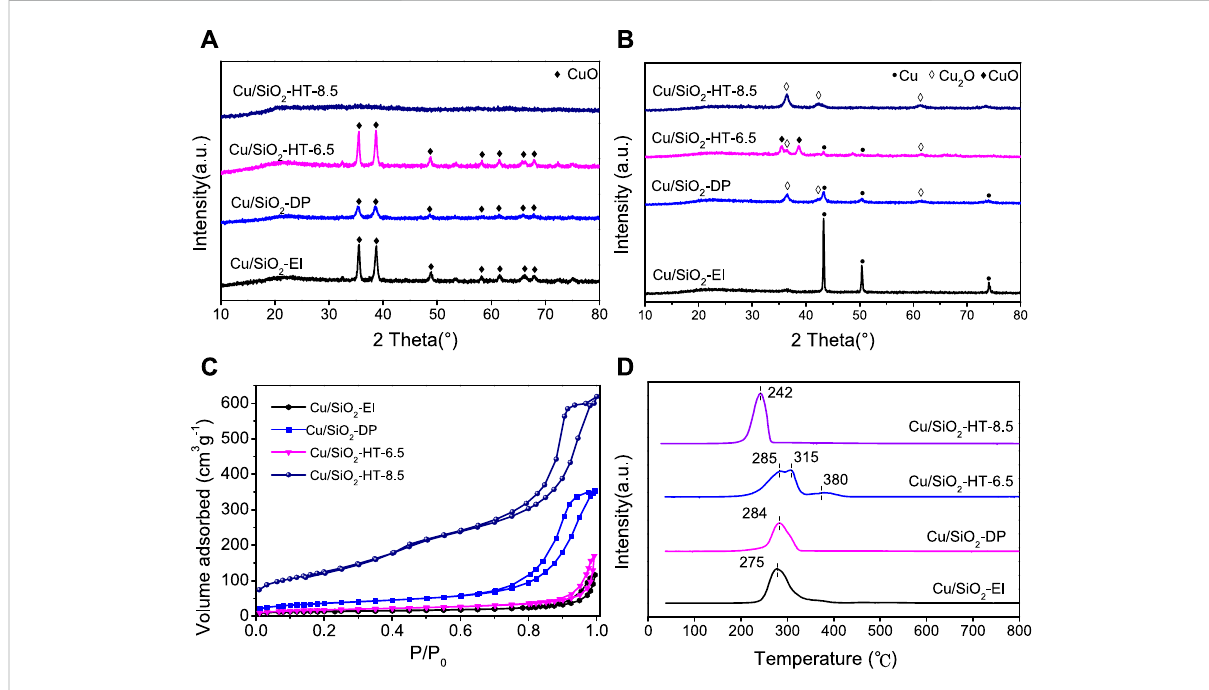
FIGURE 1 Physicochemical characterization of Cu/SiO 2 catalysts prepared by different method. (A) XRD patterns of Cu/SiO 2 catalysts before reduction; (B) XRD patterns of Cu/SiO 2 catalysts after reduction; (C) N 2 adsorption-desorption isotherm of Cu/SiO 2 catalysts; (D) H 2 -TPR pro fi les of Cu/SiO 2 catalysts.